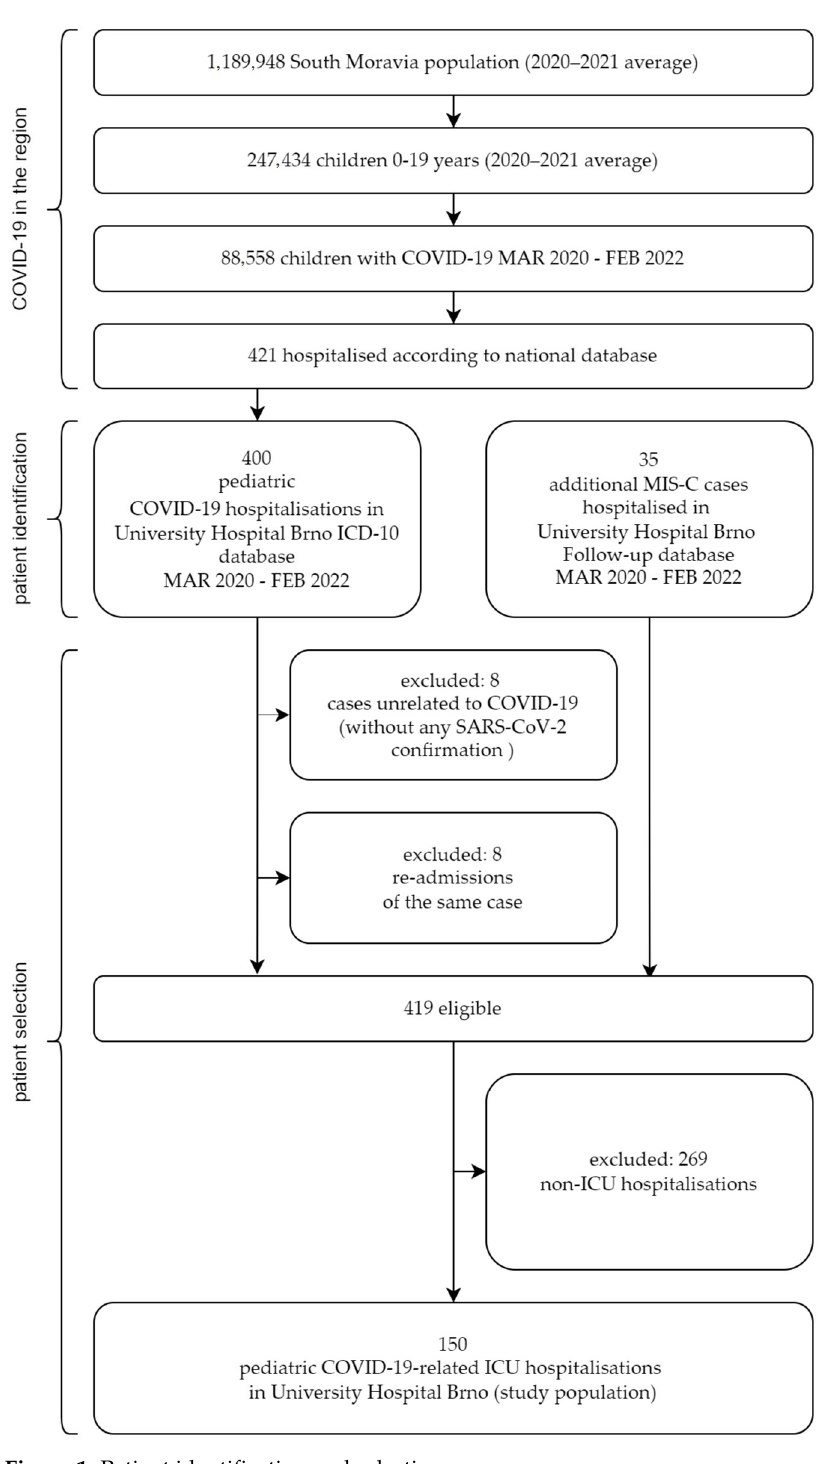
Figure 1. Patient identification and